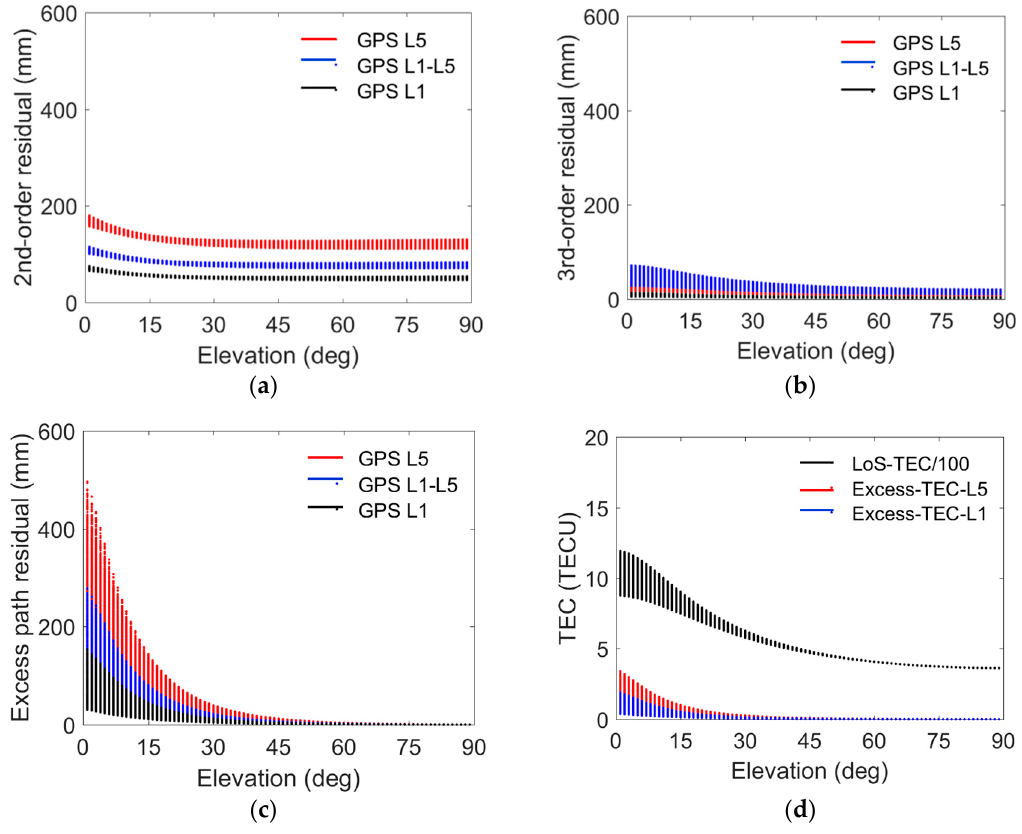
Figure 9. Top left ( a ) and top right ( b ) plots give ray-tracing estimates of second- and third-order group delay. Bottom left panel ( c ) shows geometric bending (i.e., excess path length) for GPS L1, L5, and combined L1–L5 signals whereas right panel ( d ) shows excess TEC in comparison with line of sight (LoS) TEC variation.